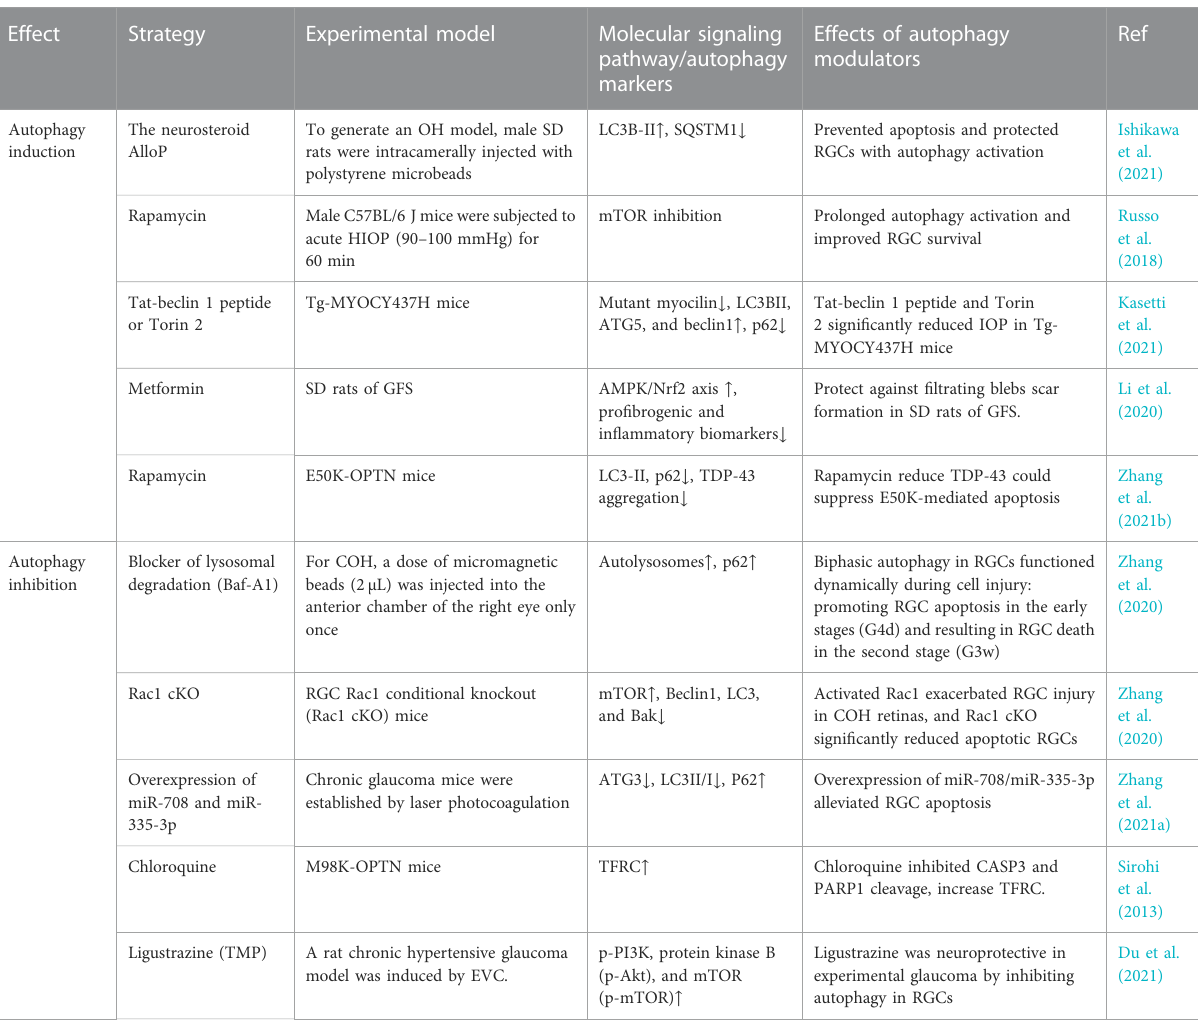
TABLE 2 Strategies for glaucoma treatment involving